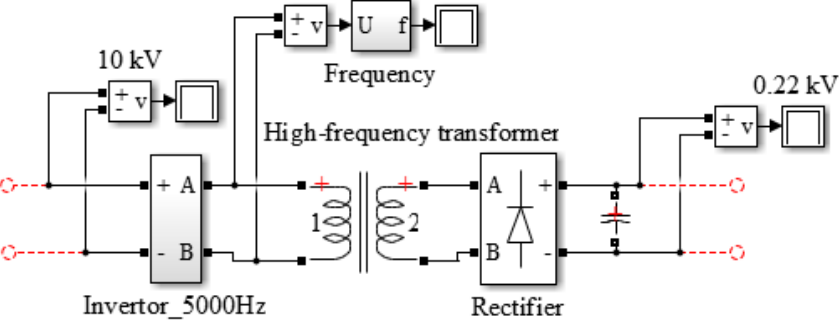
Figure 2. Structure of the MATLAB model of a power router for DC grids.